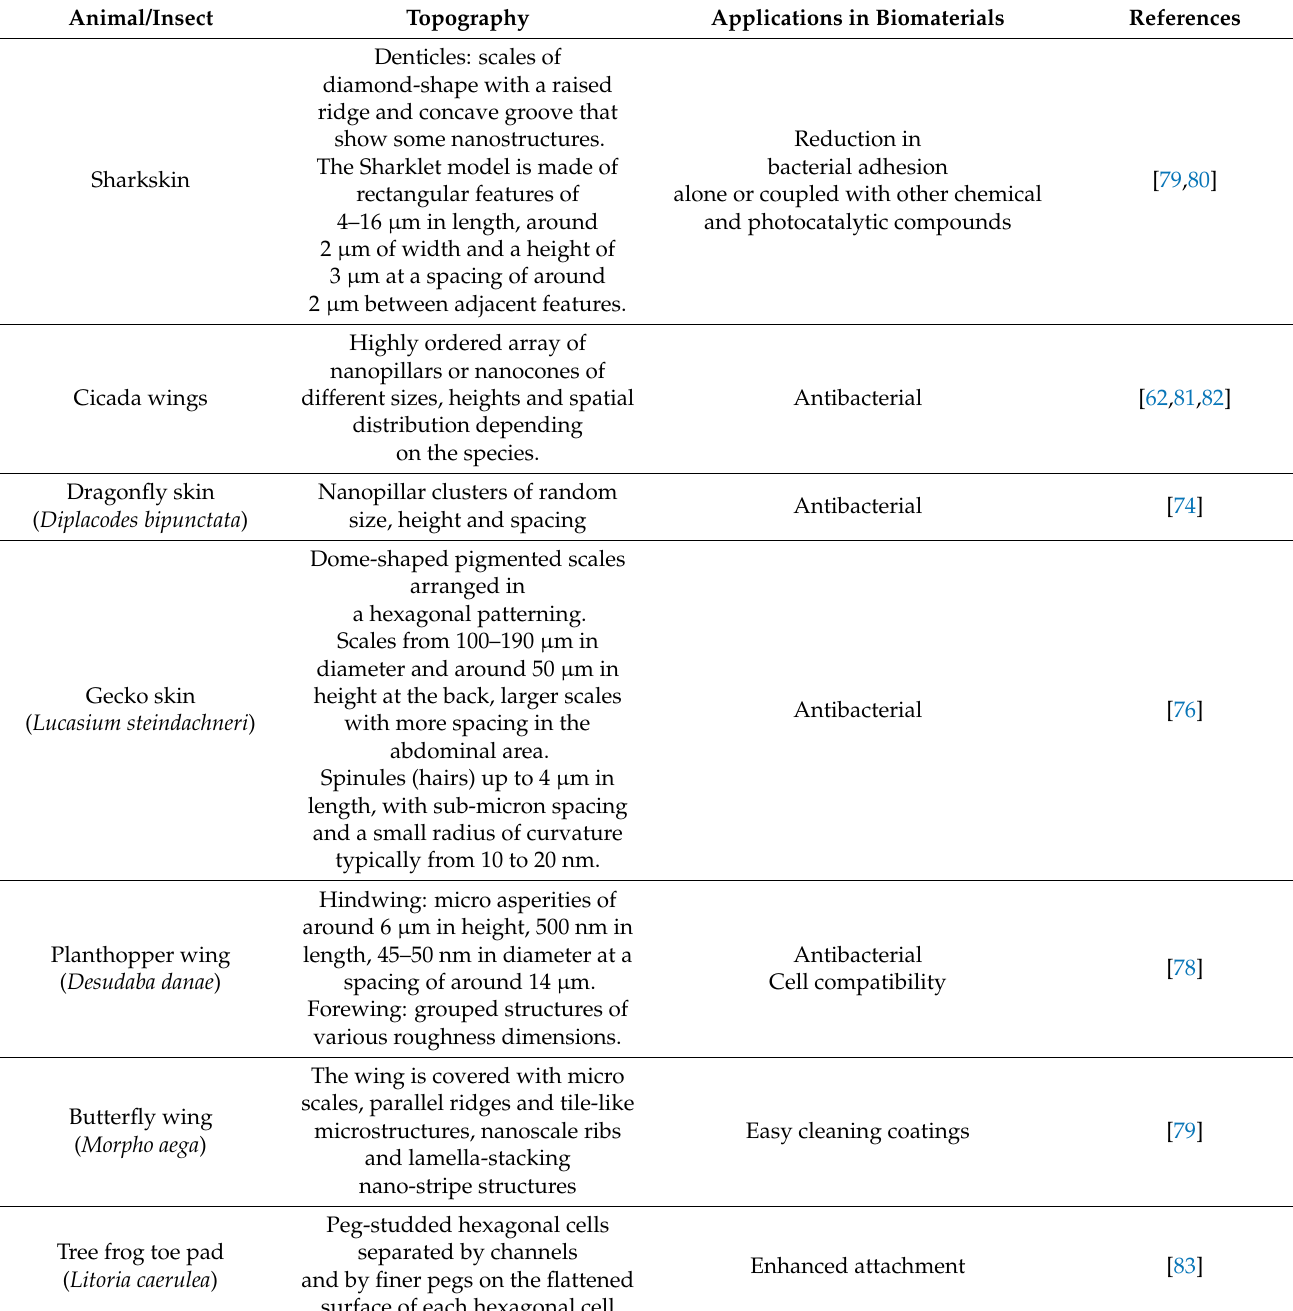
Table 1. Topographic features and biomedical applications of different animal and insect